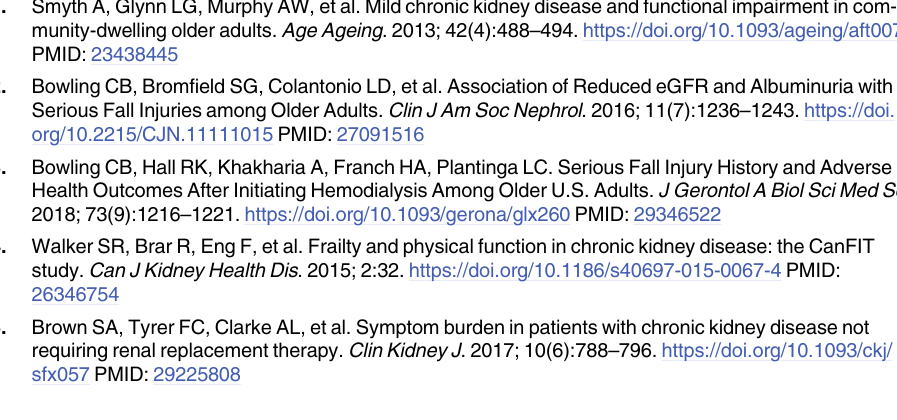
S1 Table. Analysis population compared to participants excluded from analysis from the entire Health ABC population (N = 3075). S2 Table. NCV changes over time (N = 537). S3 Table. CMAP changes over time (N = 661). S4 Table. Monofilament testing over time (N = 1035). S5 Table. Symptoms at initial visit and follow up years for all participants (N = 1121).